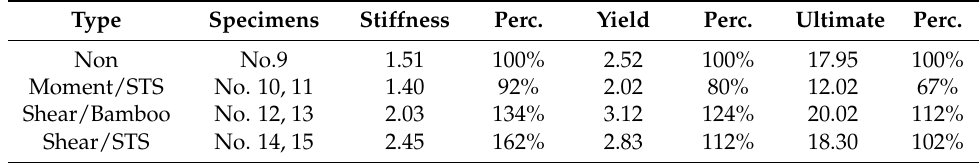
Table 7. Efficiency of preventing reinforcement for shear behaviour